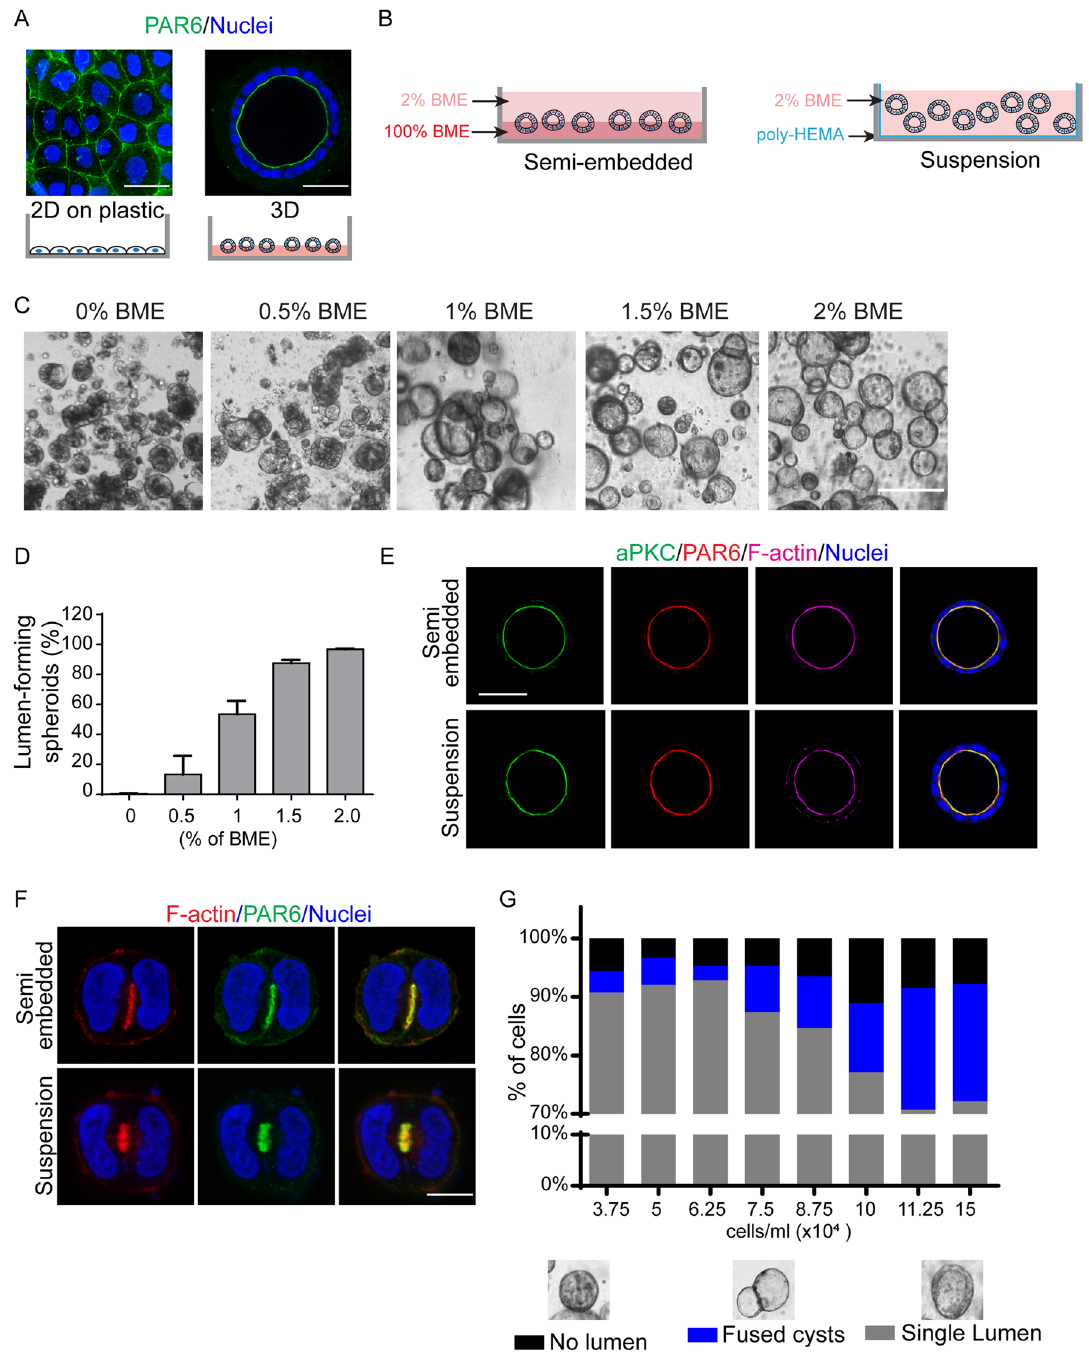
Figure 1. Suspension culture of Caco-2 cells supports lumen formation. ( A ) Confocal images for PAR6B (green) in 2D and 3D Caco-2 cells. ( B ) Schematic showing 3D organotypic cell culture model for semi- embedded and suspension Caco-2 cells. ( C ) Brightfield images showing the phenotype of 3D organotypic suspension Caco-2 cells in different percentage (0–2%) of BME. ( D ) Quantification of the percentage of lumen-forming in different percentage (0–2%) of BME. ( E ) Confocal images were captured of cells cultured in 3D semi-embedded or suspension cultures and immunostained for aPKC (green), PAR6 (red), and F-actin (magenta). ( F ) Confocal images of 2-cell structures grown as 3D semi-embedded or suspension cultures and immunostained for PAR6 (green) and F-actin (red). ( G ) The quantification of Caco-2 cells phenotypes (no lumen, fused cysts, single prominent cyst) following culture at various cell densities (3.75–15 × 10 4 cells/ml) in suspension cell culture. Cells were seeded in 8-well ibidi slides. Scale Bars: A, E, 50 µm; C, 100 µm; F, 10